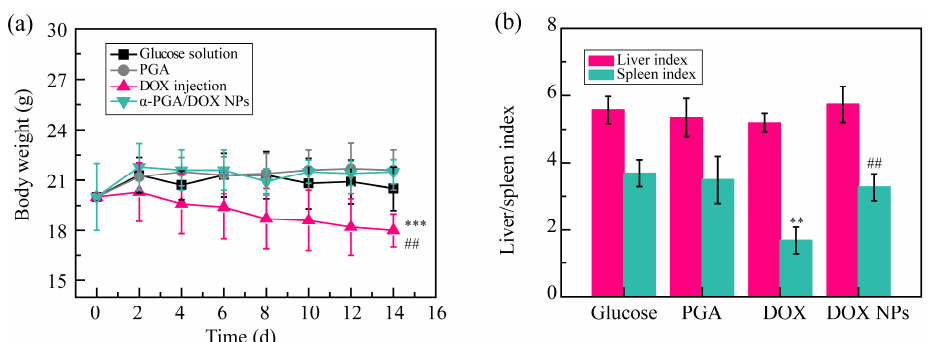
Figure 7. Systemic toxicity assessment: body weight change curves ( a ) and liver/spleen index ( b ) ( n = 10). ** p < 0.01, *** p < 0.001, vs. glucose solution; ## p < 0.01, vs. DOX injection.